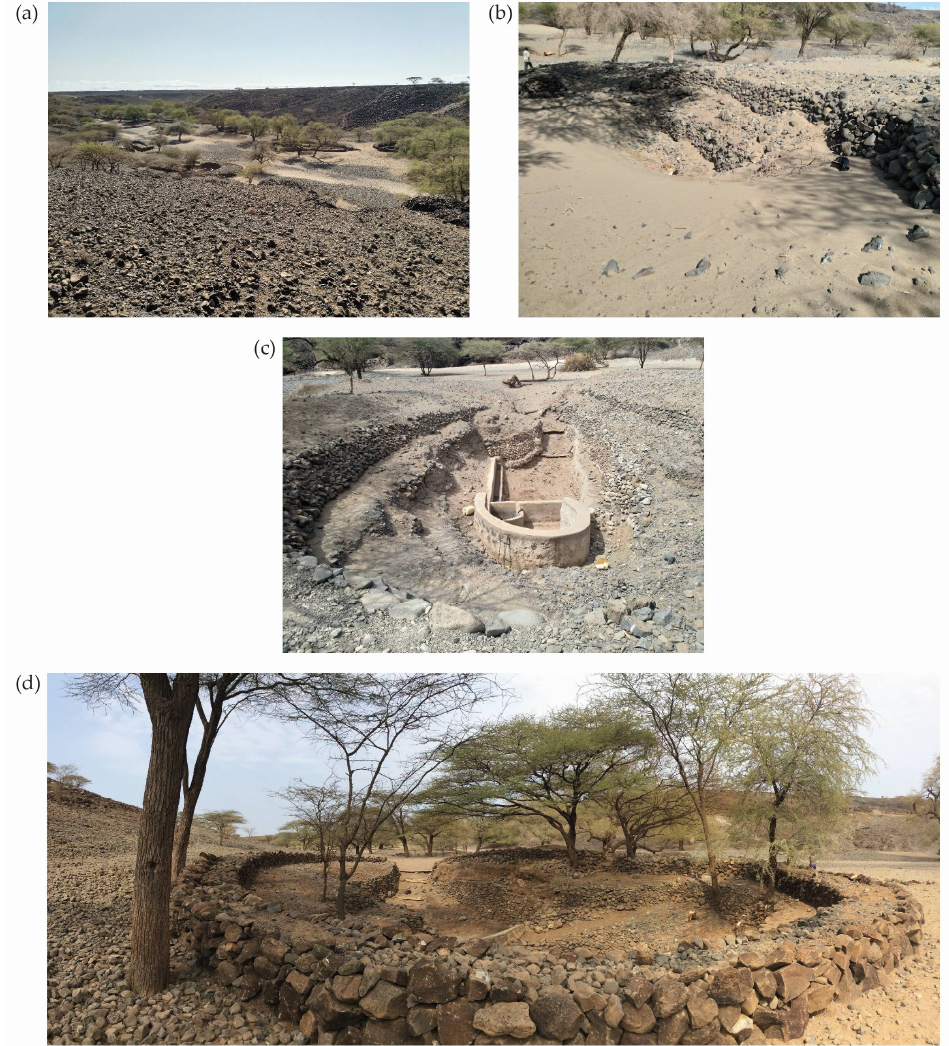
Figure 3. Landscape setting and examples of operational and disused Gabra wells at El Hadi, N. Kenya. ( a ) Landscape setting of the wells, ( b ) Collapsed well, ( c ) Operational well, ( d ) Enclosed well. Photos: Paul Lane & Freda M’Mbogori,